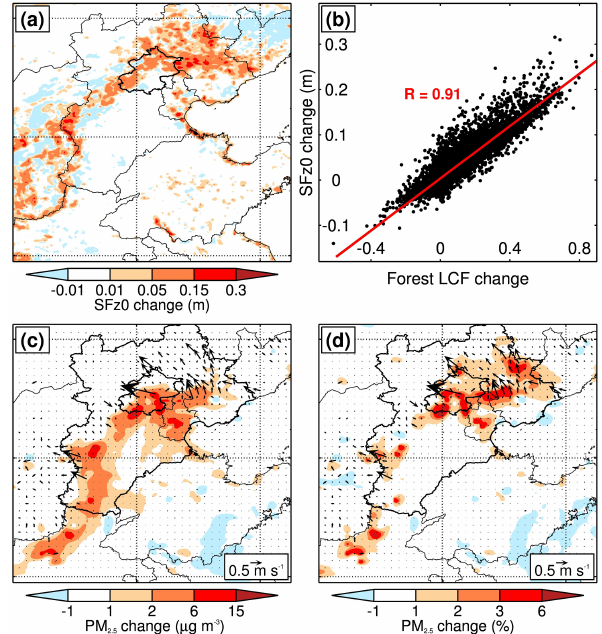
Figure 5. (a) SFz0 change from 2001 to 2013, and (b) its correla- tion with the forest LCF change; horizontal distribution of (c) abso- lute and (d) relative near-surface PM 2 . 5 mass concentration changes caused by the afforestation. The wind field changes are shown in black arrows in (c) and (d)